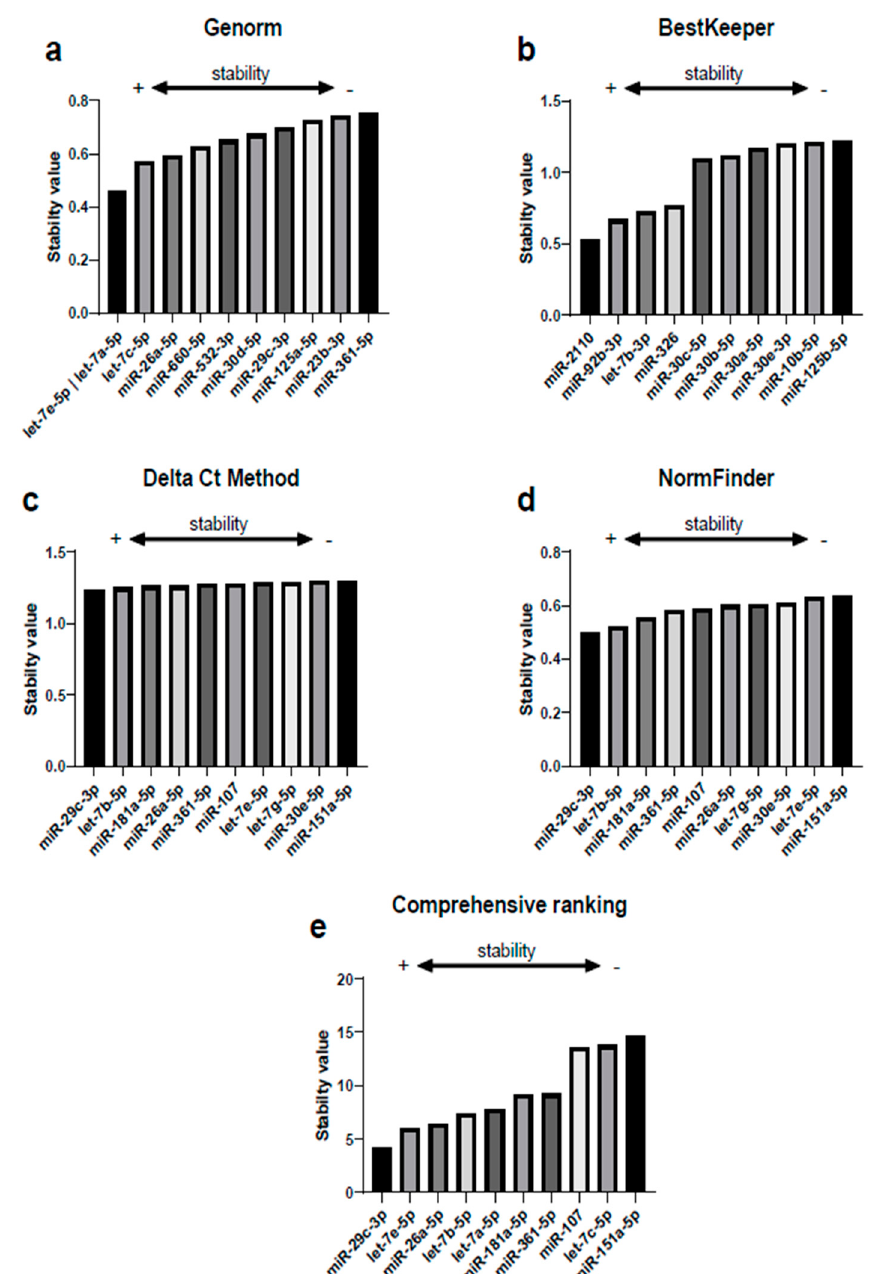
Figure 3. Selection of candidate miRNA normalizers and analysis of their stability conducted with the comprehensive tool RefFinder. Each graph represents the best 10 reference miRNAs selected by each algorithm: ( a ) Genorm, ( b ) BestKeeper, ( c ) Delta Ct method, ( d ) NormFinder and ( e ) Comprehensive ranking. The lower the stability value, the higher the stability of each miRNA.